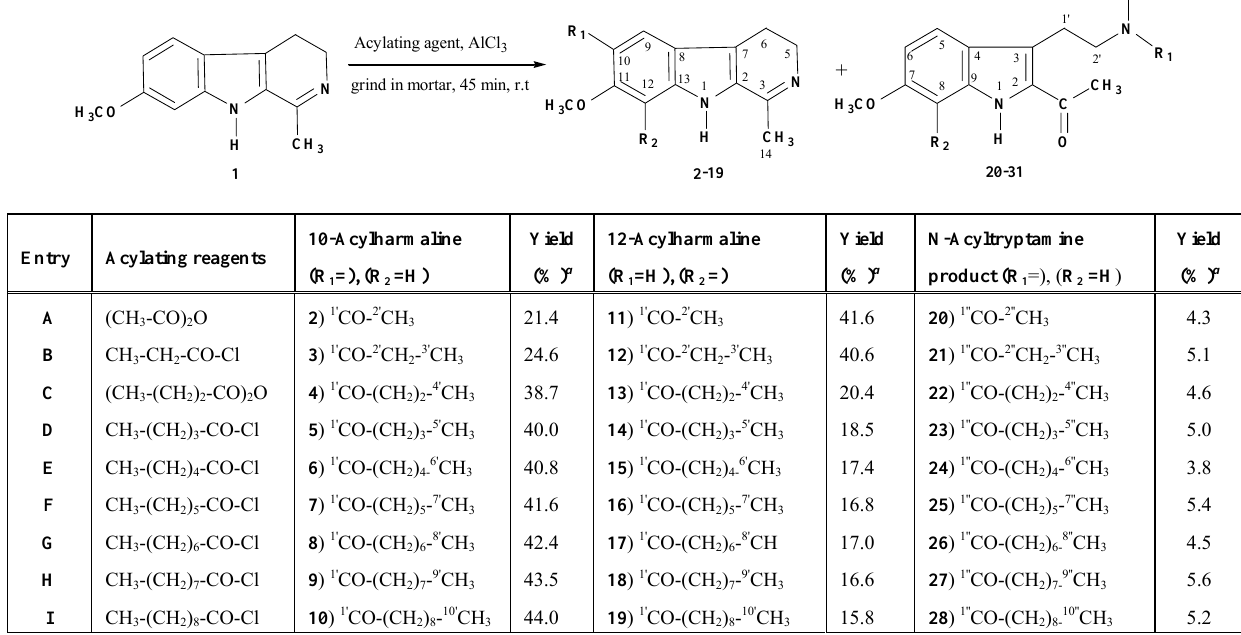
Table 1. Friedel-Crafts Acylation of Harmaline ( 1 ) under Solvent-Free